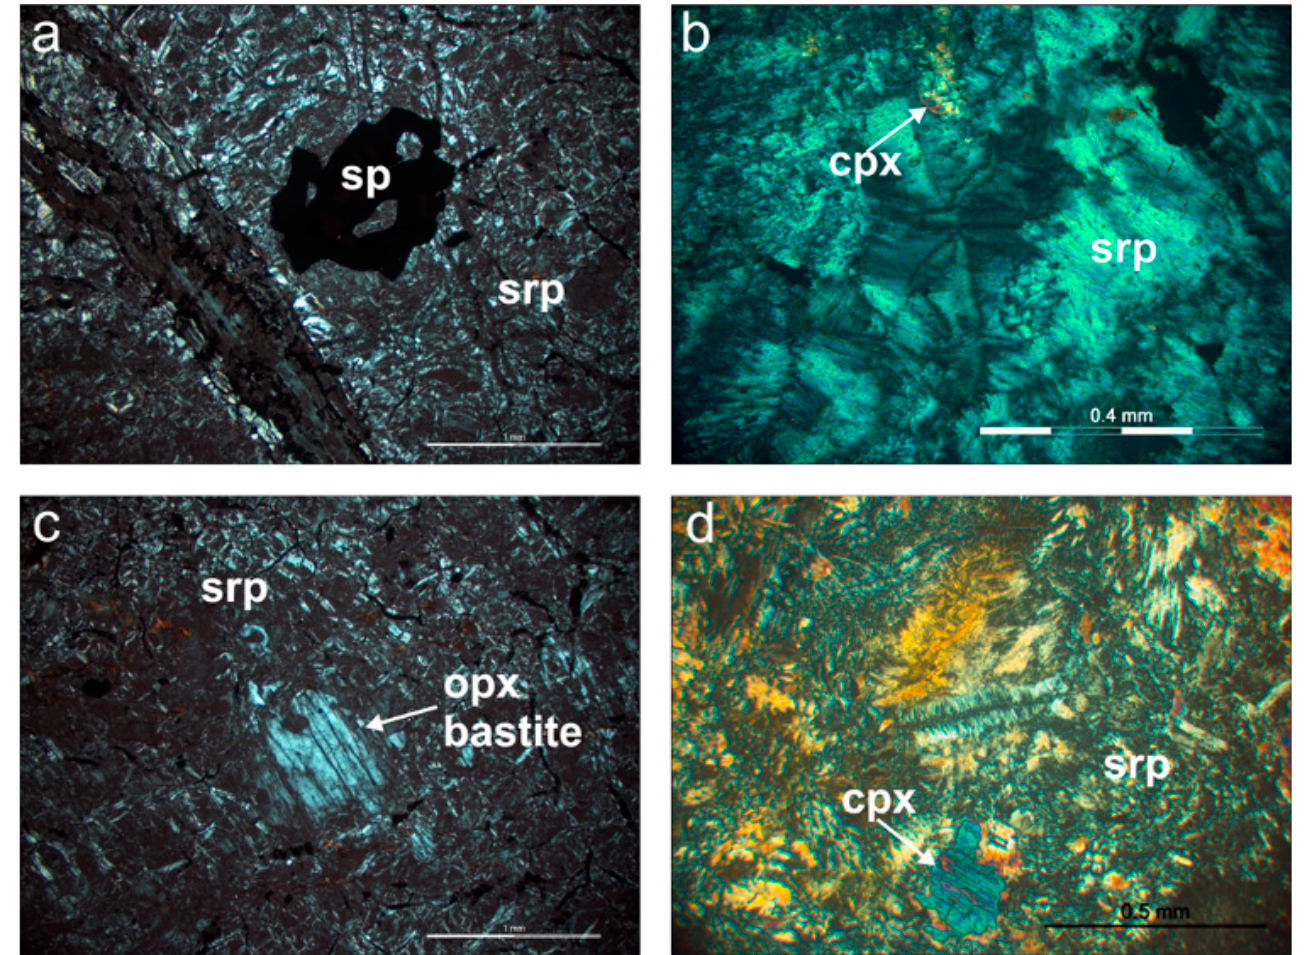
Figure 3. Photomicrographs of: ( a ) spinels in a mass of serpentine in a serpentinized lherzolite (sample, SV5, XPL); ( b ) relics of clinopyroxene and mesh texture of serpentine presented in a serpentinized lherzolite (sample SV4, XPL); ( c ) bastitic texture of serpentine in a serpentinized harzburgite (sample SV6, XPL); ( d ) relics of clinopyroxene and mesh texture of serpentine presented in a serpentinized harzburgite (sample SV7, XPL). Abbreviations: opx: orthopyroxene, cpx: clinopyroxene, srp: serpentine, sp: spinel.